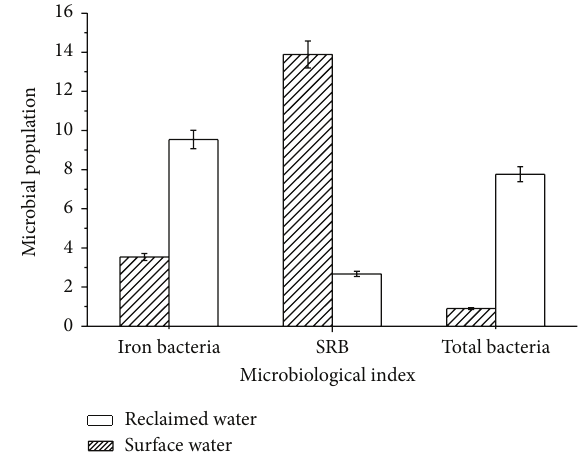
Figure 8: Microorganism comparisons of foulant in recycling cool- ing water system makeup by municipal reclaimed water and surface water. Note: the unit of the total number of bacteria was 10 6 cfu/g; unit of SRB and iron bacteria was 10 3